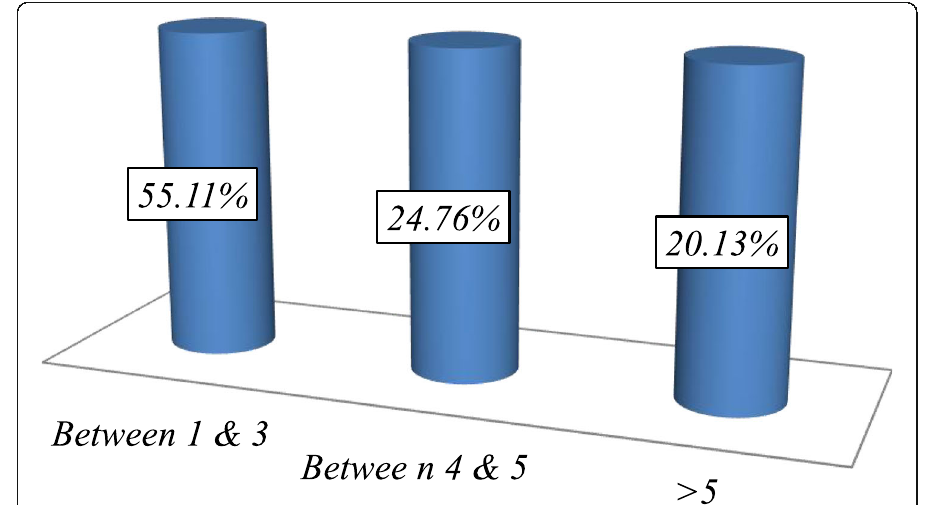
Fig. 6 Enterprises ’ business experience. Source: author ’ s computation based on firm survey